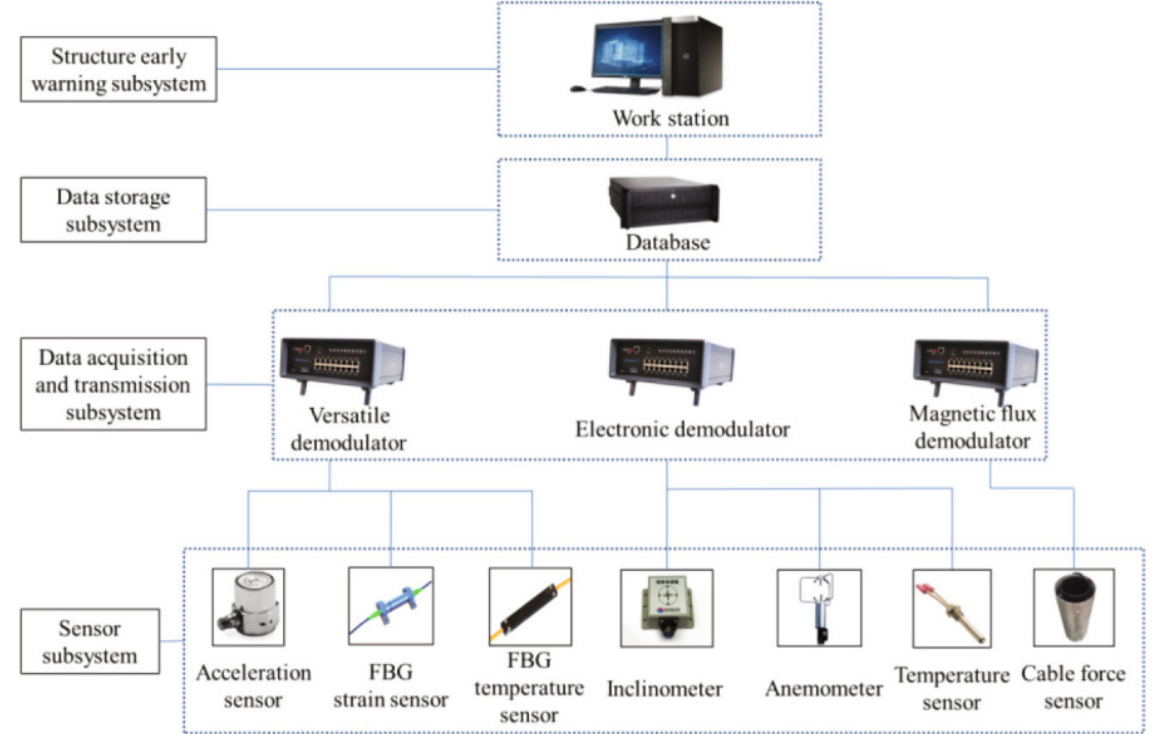
Figure 23. The framework of the SHM system for the cable–membrane structure of Yueyang Airport, China [32].